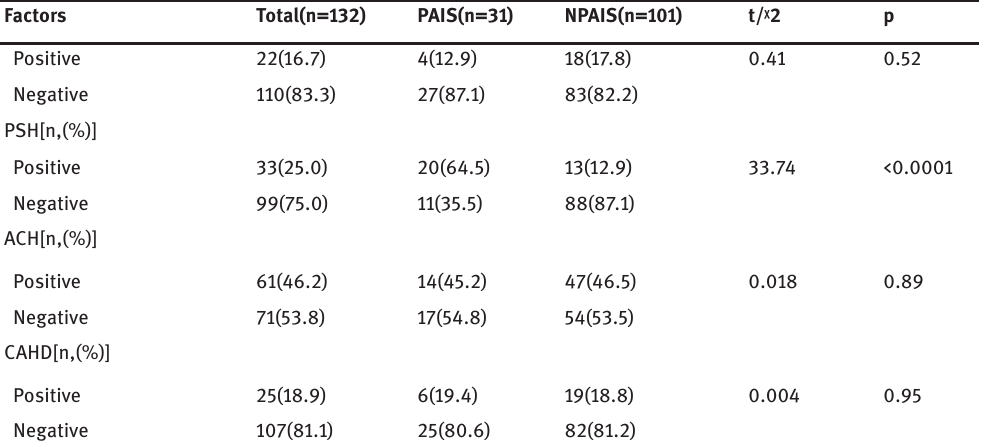
Table 2: Indenpendt risk factors for PAIS analyzed by logistic regression